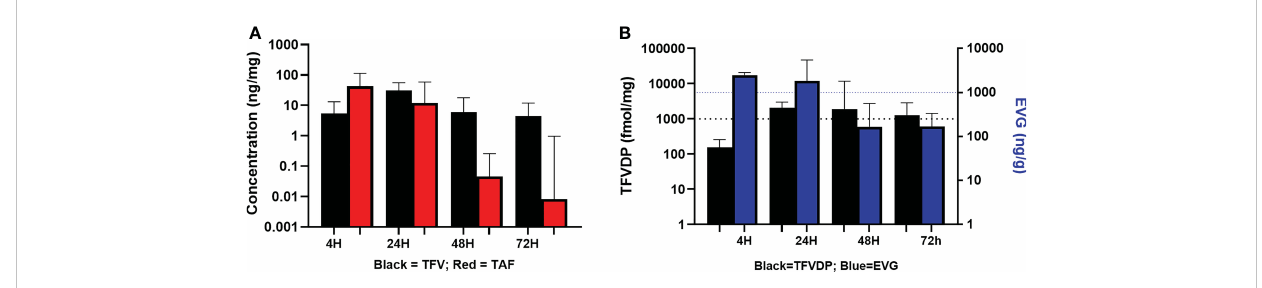
FIGURE 3 Concentrations of Analytes in Vaginal Tissue. (A) TFV and TAF Concentrations in Vaginal Tissue. Black = TFV in ng/mL; Red = TAF in ng/mL. (B) EVG and TFV-DP Concentrations in Vaginal Tissue. Black = TFV-DP in fmol/mg; Blue = EVG in